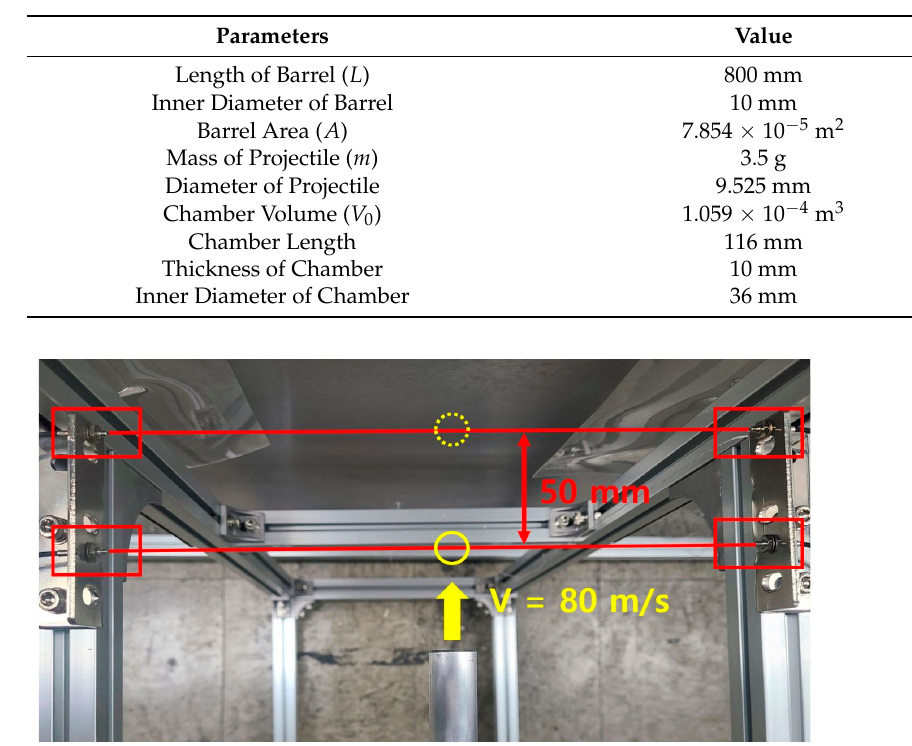
Figure 14. Design of launch device. Table 2. Design parameters of launch device.